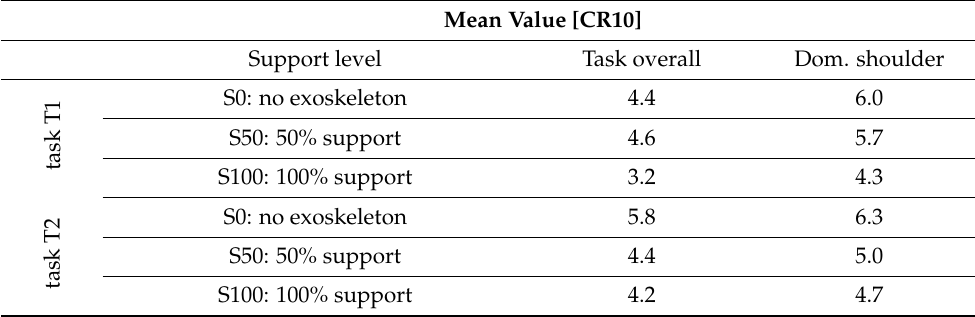
Table 4. Borg ratings [CR10] of perceived exertion on tasks T1 and T2. The perceived exertion for tasks T1 and T2 was rated lower with increasing support force. Mean Value [CR10] Support level Task overall Dom.